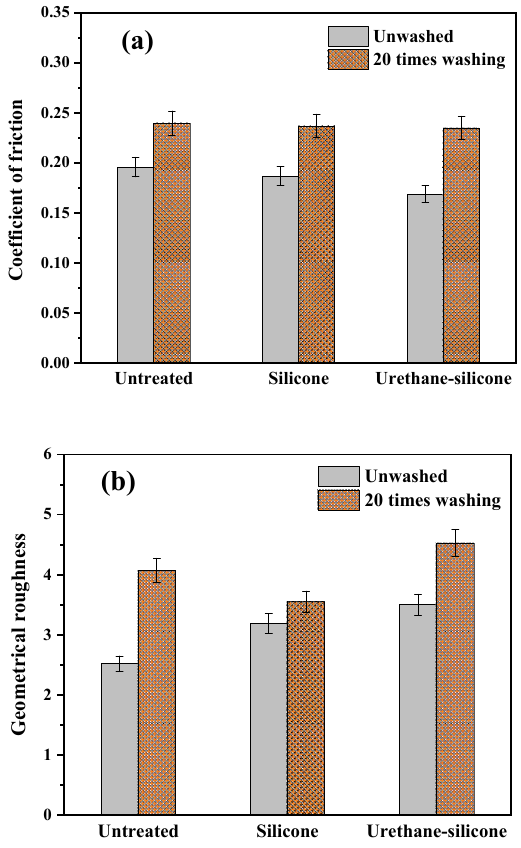
Figure 12. Surface properties of the cotton knit fabric untreated and treated with softeners. ( a ) Coefficient of friction; ( b ) geometrical roughness.